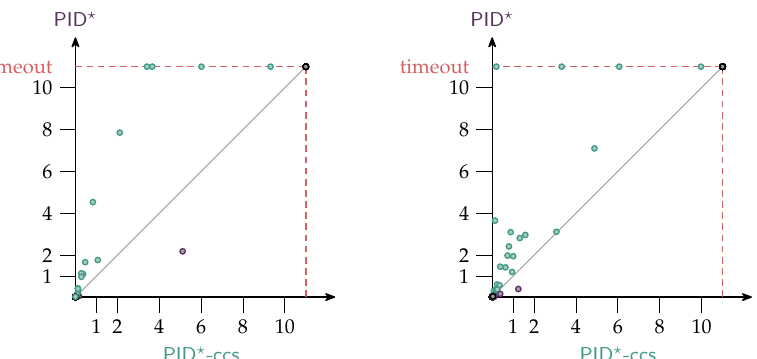
Figure 8. Scatter plots that show the performance of PID (cid:63) without color coding sieves compared to the performance of the solver with them enabled ( γ = 1 and a randomly generated coloring is used). The left plot contains the DIMACS graph coloring instances, the right plot the PACE 2020 test set. Each point corresponds to an instance; the x -axis is the time needed by the solver using color coding sieves and the y -axis without using this feature. The color of the dot indicates which version was better; it is gray if they are equal. If a solver needed more than 10 min for an instance, the coordinate is set to the red dotted